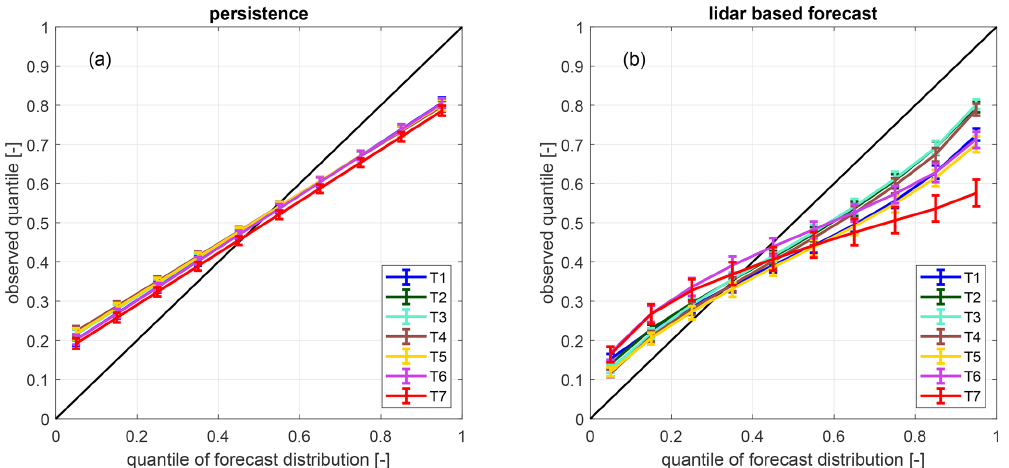
Figure 15. Reliability diagrams of all free-flow turbines of (a) the lidar-based forecast and (b) persistence for stable and neutral stratification. The 95% confidence intervals are visualized as error